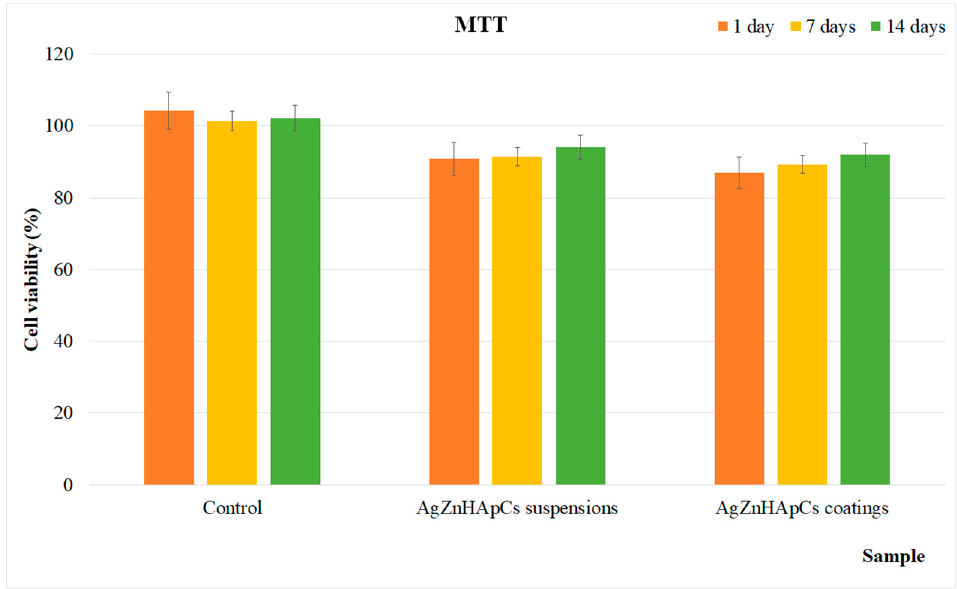
Figure 8. MTT assay for the viability of hFOB 1.19 cells incubated on AgZnHApCs suspensions and coatings for 1 day, 7 days and 14 days. The results are presented as means ± standard error of the mean of four independent experiments. The data were statistically analyzed by using a t -Test: Paired Two Sample for Means and p values, p ≤ 0.05, were accepted as statistically significant.